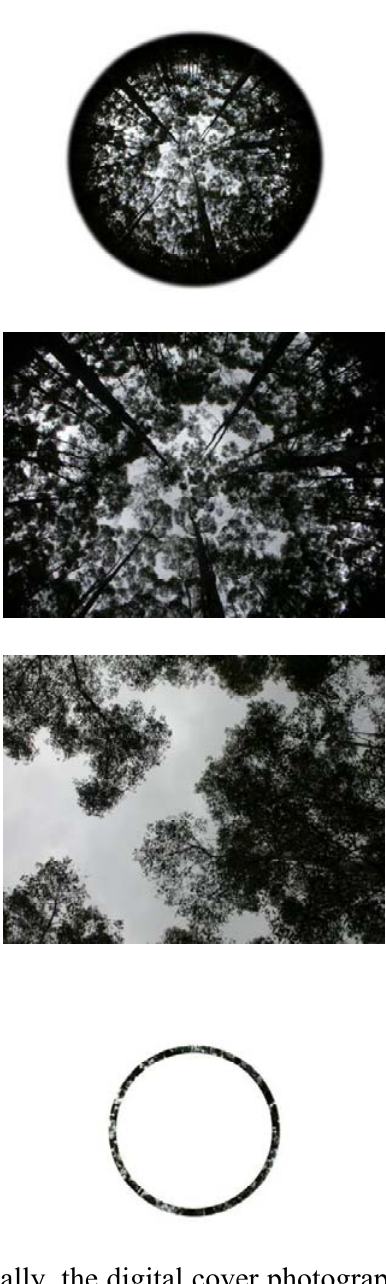
Figure 1. Comparison of wide-angle fisheye and 57° photographic images with narrow FOV cover